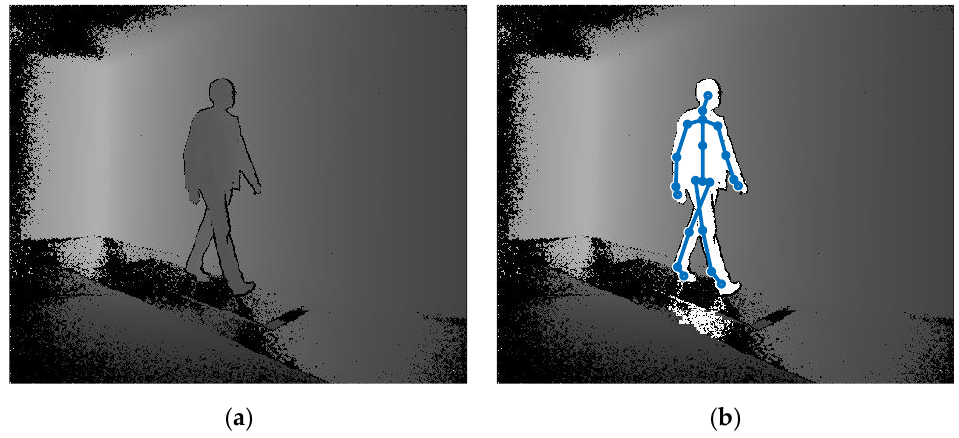
Figure 1. ( a ) An exemplary depth image acquired using a Kinect v2 device, in which brighter pixels indicate larger distances from the device; ( b ) The results of the detection of a human silhouette and the results of the localisation of 21 anatomical landmarks, obtained using the algorithm implemented in the Kinect v2 device.